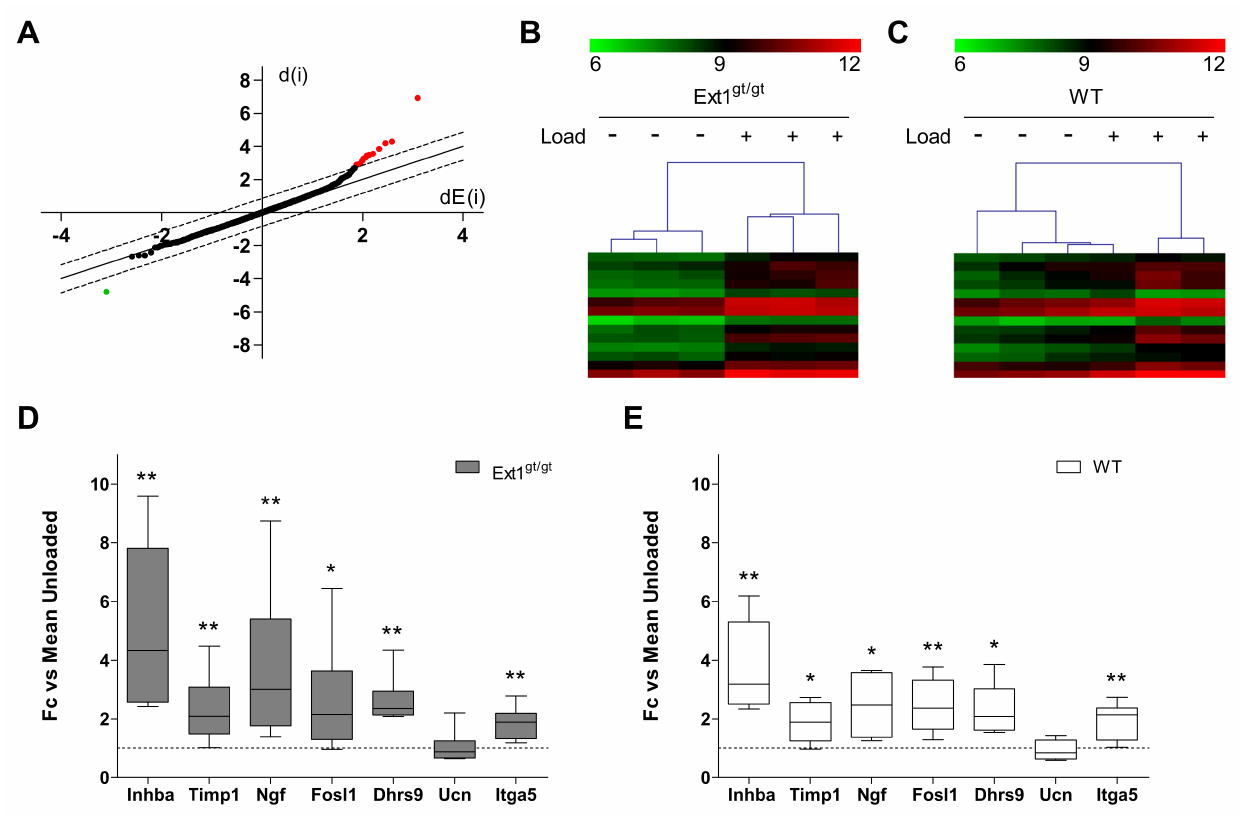
Figure 4. Influence of dynamic compression on global gene expression in HS-deficient and WT cartilage. ( A – C ) Ext1 gt/gt and WT cartilage was loaded on day 14 of differentiation culture. Total RNA was isolated from three loaded and non-loaded constructs per group and subjected to whole transcriptome analysis. ( A ) Microarray results depicted as scatter plot following data processing by Significance Analysis of Microarrays (SAM) comparing loaded and non-loaded Ext1 gt/gt engineered cartilage. The observed relative difference d(i) was plotted against the expected relative difference dE(i) for non-loaded and loaded groups. Dashed lines define the difference between d(i) and dE(i) beyond which mRNAs were considered significant at a median false discovery rate (FDR) < 0.05. In red: mRNAs significantly higher for loaded vs. non-loaded group; in green: mRNAs significantly lower in loaded vs. non-loaded group. ( B ) Dendrogram of 14 mRNAs significantly regulated between loaded (+) and non-loaded (-) Ext1 gt/gt samples. ( C ) Dendrogram of WT samples using the 14 hits from the Ext1 gt/gt groups as input. Data are visualized as heatmap of log-2 transformed intensities ( n = 3, 3 donors). ( D , E ) Expression levels of mRNAs (selection from Table 1) in engineered Ext1 gt/gt ( D ) and WT ( E ) cartilage in response to loading. Total RNA was isolated from 6 control and compressed samples per group and subjected to RT-qPCR analysis. Values were normalized to reference genes Hprt and Rpl19 and non-loaded samples were set to 1 (dashed line). Data are shown as box plots as described in Figure 1 ( n = 6, 5 donors). Loaded vs. non-loaded: Mann–Whitney U test * p < 0.05, ** p <